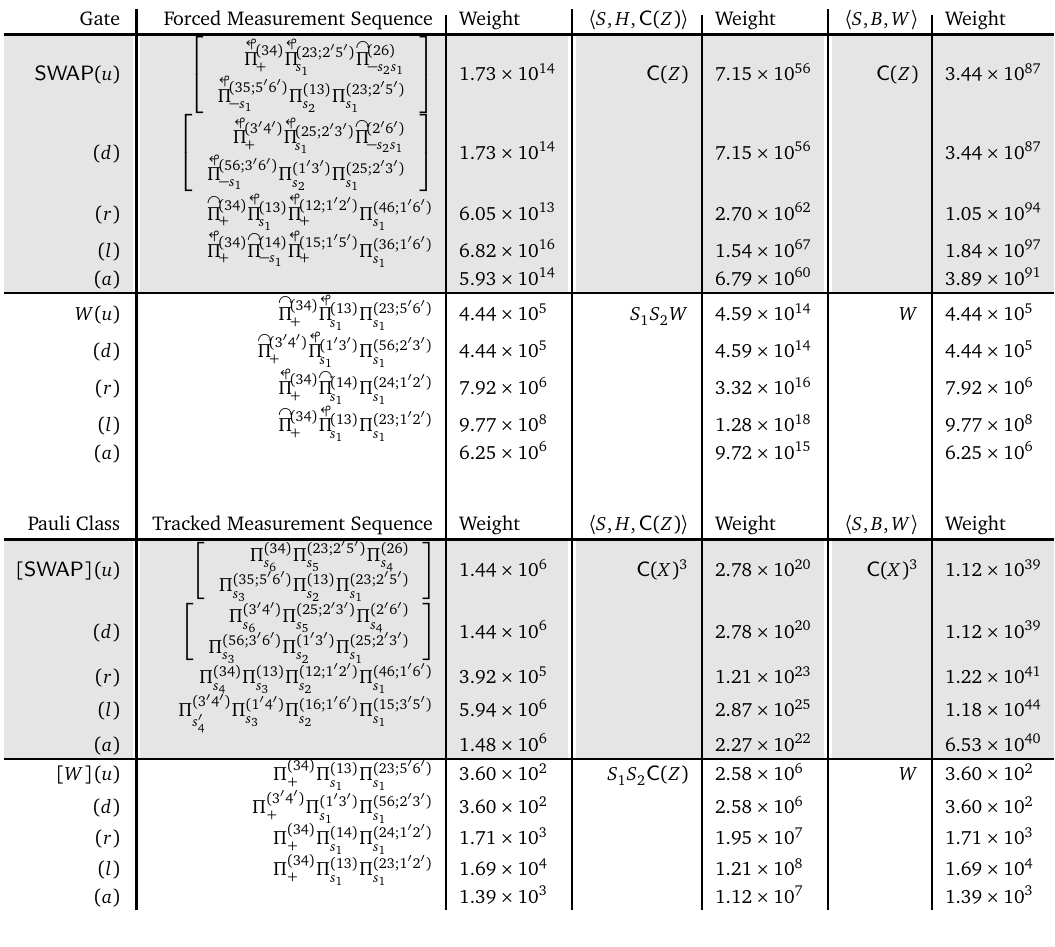
Table 27: Minimal difficulty weight measurement sequences for the two-qubit SWAP and W gates when using forced-measurement methods and the Pauli cosets of SWAP and W when using Majorana-Pauli tracking methods. For compari- son, we also present the corresponding realization of the gates formed by using SWAP = C ( X ) C ( X ) C ( X ) with C ( X ) as given in Tables 24 and 12 21 12 12